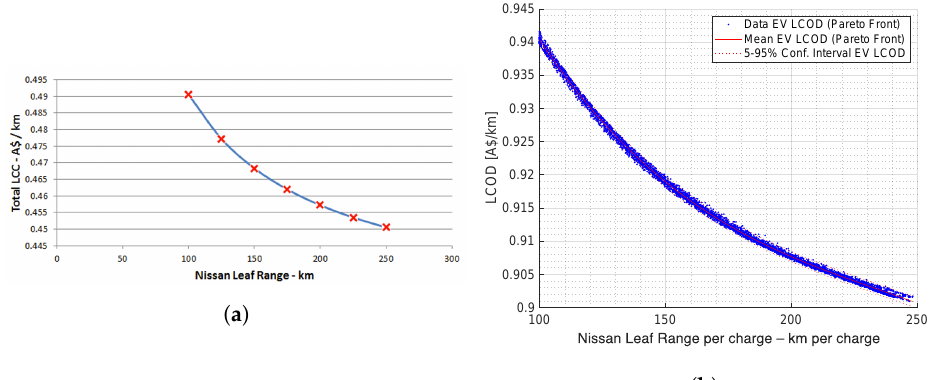
Figure 9. Total LCC and LCOD versus Range per charge—km per charge. ( a ) Results with Method of [12] with LCC. ( b ) Results with proposed method